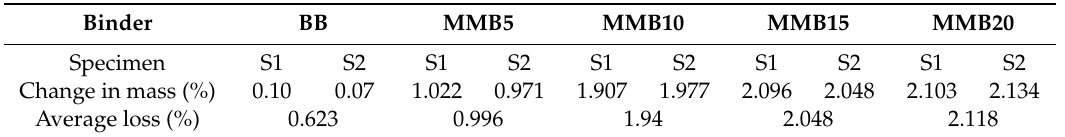
Table 7. Loss on heating for Bitumen binders (BB) and molasses modified binders (MMBs).